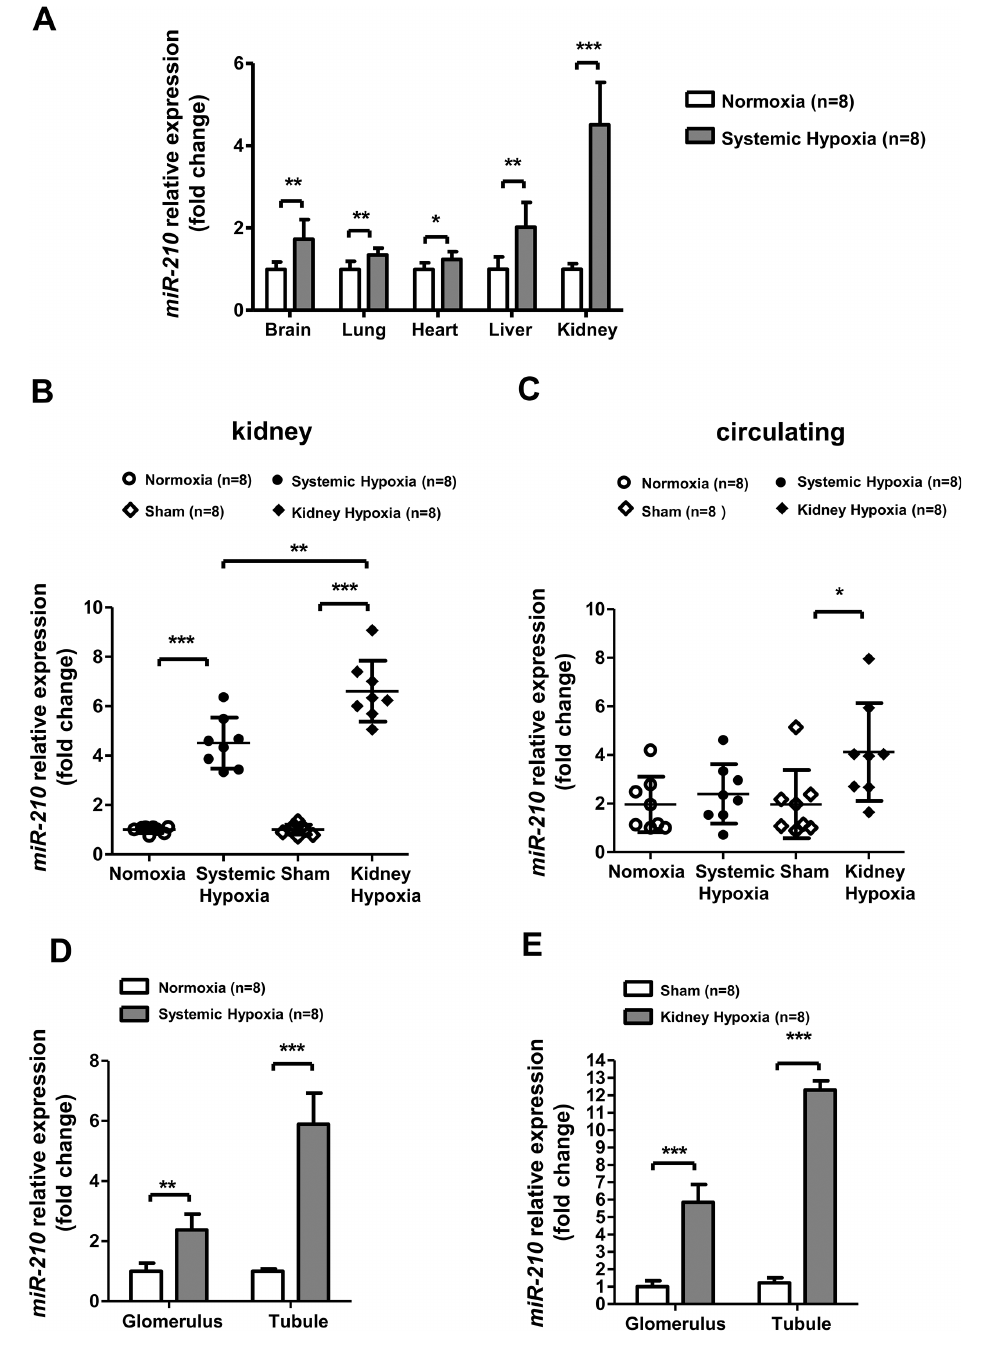
Figure 3. miR-210 increased significantly in rat kidney after systemic and local kidney hypoxia, especially in tubular cells. miR-210, another target of HIF-1 α , was measured in normoxia (n = 8), systemic hypoxia (7500 m, 7 h; n = 8), sham (n = 8) and local kidney hypoxia (ischemia, bilateral, 60 min; n = 8) groups. (A) miR-210 expression in the vital organs (brain, lung, heart, liver and kidney) was measured after systemic hypoxia. (B) miR-210 expression in (B) kidney and (C) circulation were measured in the four groups. miR-210 expression in isolated primary tubular cells and glomerular cells from renal cortex after (D) systemic hypoxia and (E) local hypoxia. miR-210 expression in isolated primary tubular cells and glomerular cells from renal cortex after systemic hypoxia. miR-210 levels were measured by real-time PCR. To measure circulating miR-210 level, miR-39 was used for the spike-in. Renal miR-210 levels were normalized to RNU6, and circulat- ing miR-210 levels were normalized to miR-39. Data are shown as mean ± SD. * P < 0.05; ** P < 0.01; *** P <